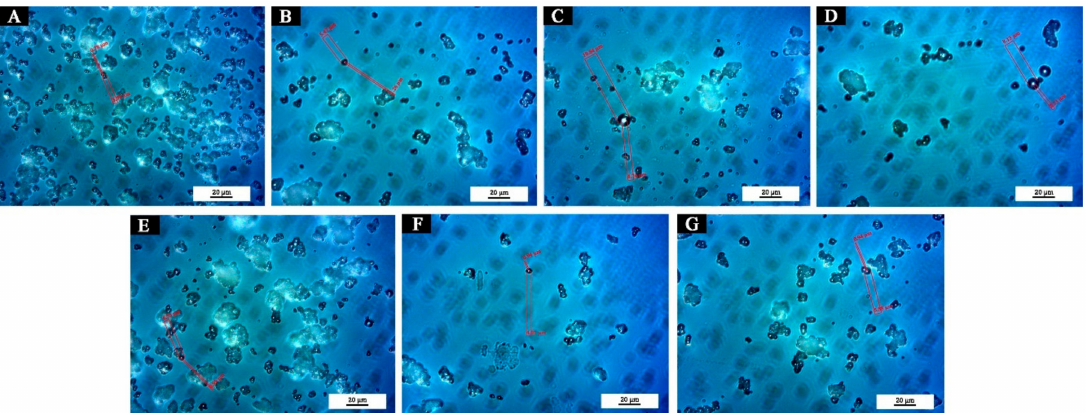
Figure 3. Optical microscope (OM) image of core size and thickness of the wall of microcapsules.